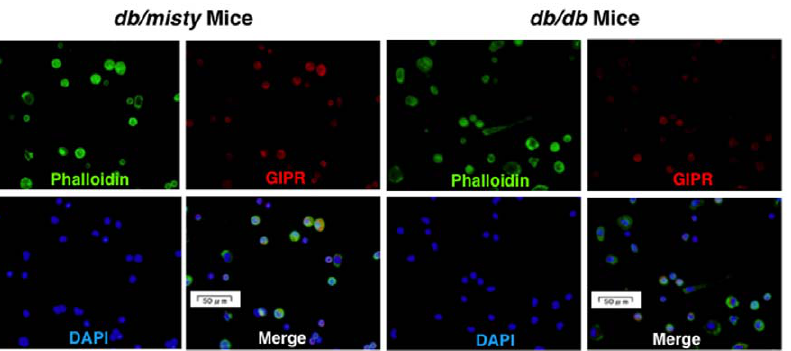
Figure 5. Expression of GIPR in exudate peritoneal macrophages from db/misty and db/db mice. GIPR was stained with goat polyclonal anti-GIPR antibody followed by anti-goat Alexa Fluor 568. Phalloidin/DAPI staining shows F-actin cytoskeleton and nuclear morphology of mouse macrophages. These images were merged. Representative results are shown.